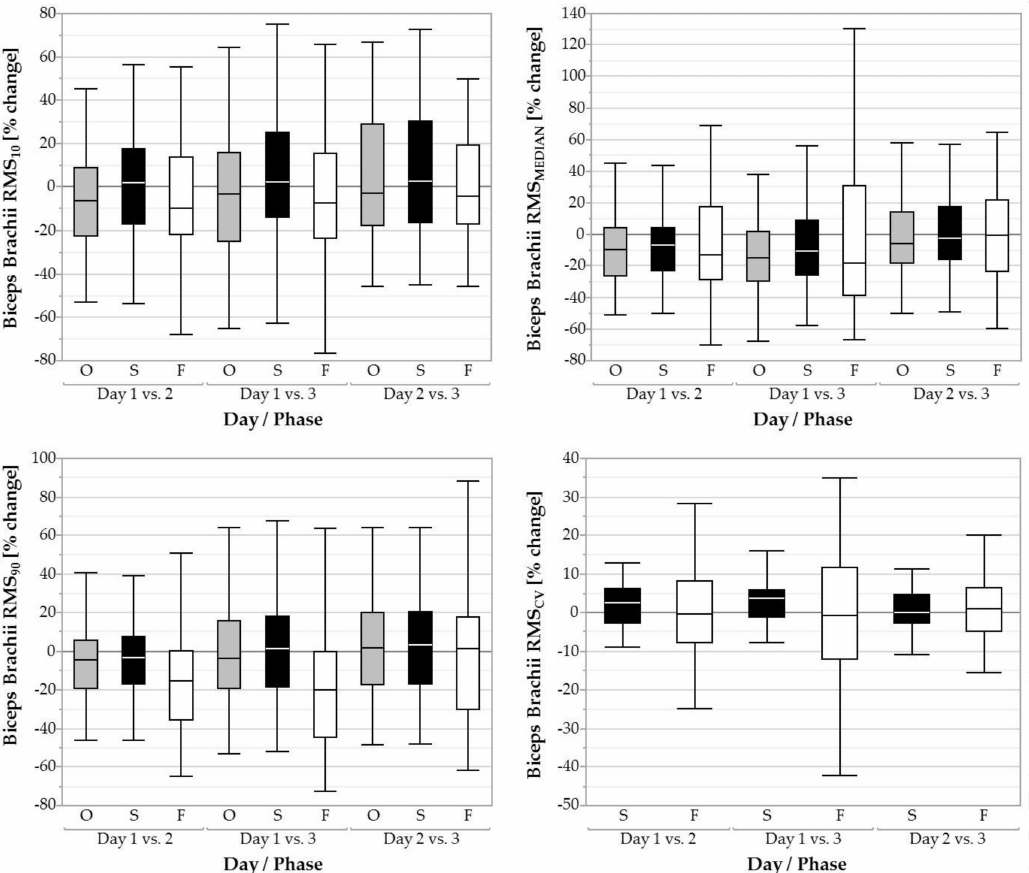
Figure 3. Boxplots of the 10th, 50th, and 90th percentile muscular activity (RMS 10 , RMS MEDIAN, RMS 90) and coefficient of variation (RMS CV ) of the biceps brachii over three days for the overall task (O, grey filled boxplots), the screwing phases (S, black filled boxplots), and the fastening phases (F, white filled